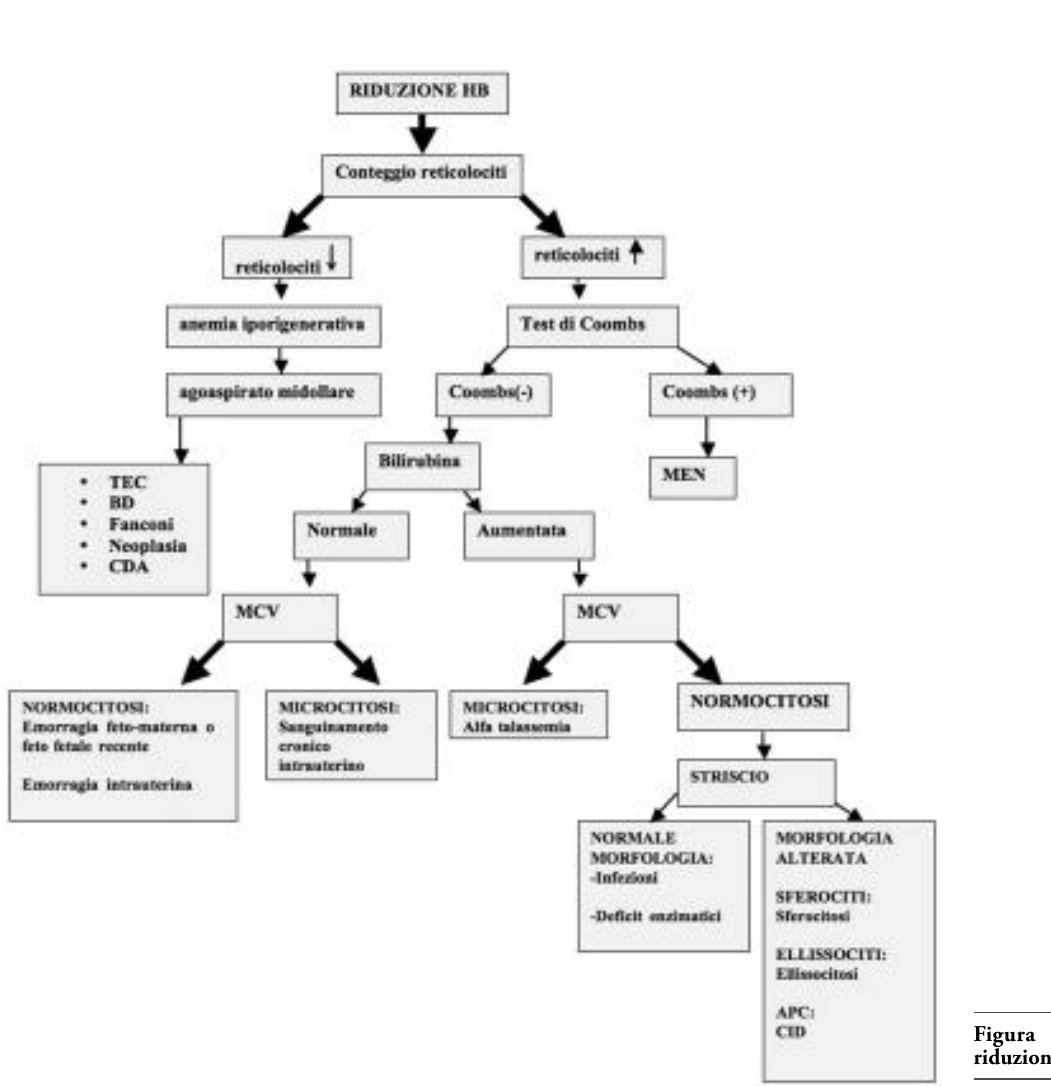
Figura 1. Meccanismo di riduzione